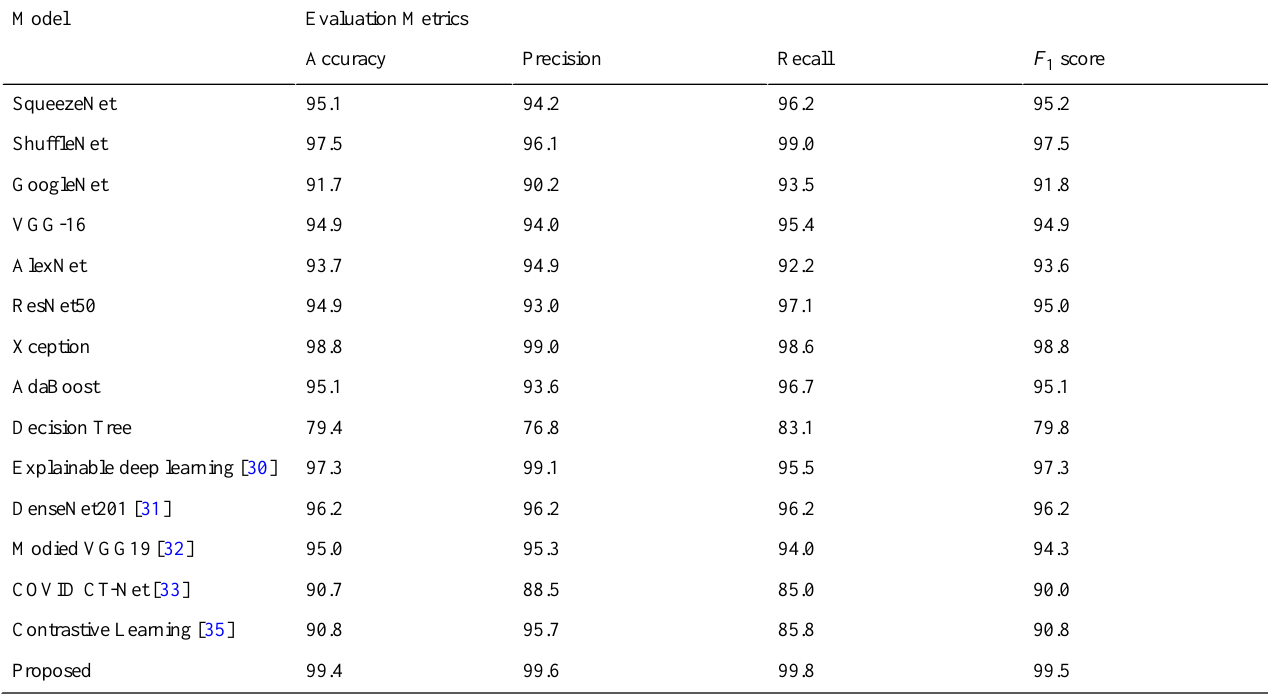
Table 4. Comparison of the performance of different models for detecting COVID-19 using various evaluation